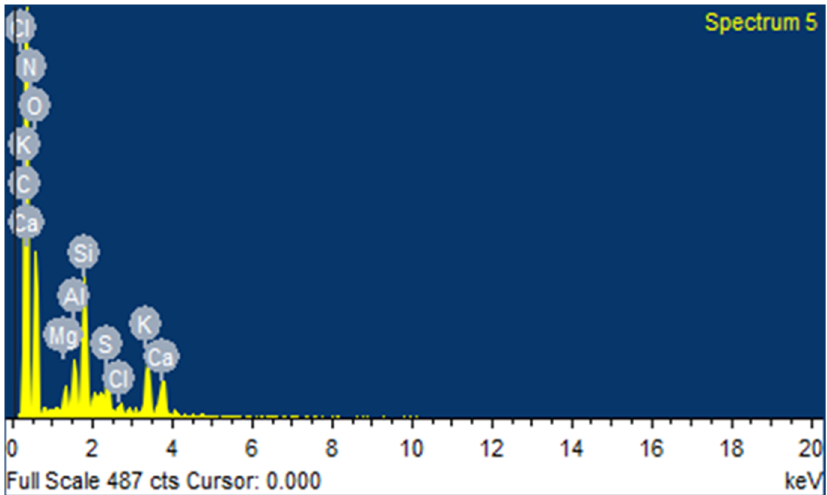
Figure 1. EDS of poultry litter through SEM.